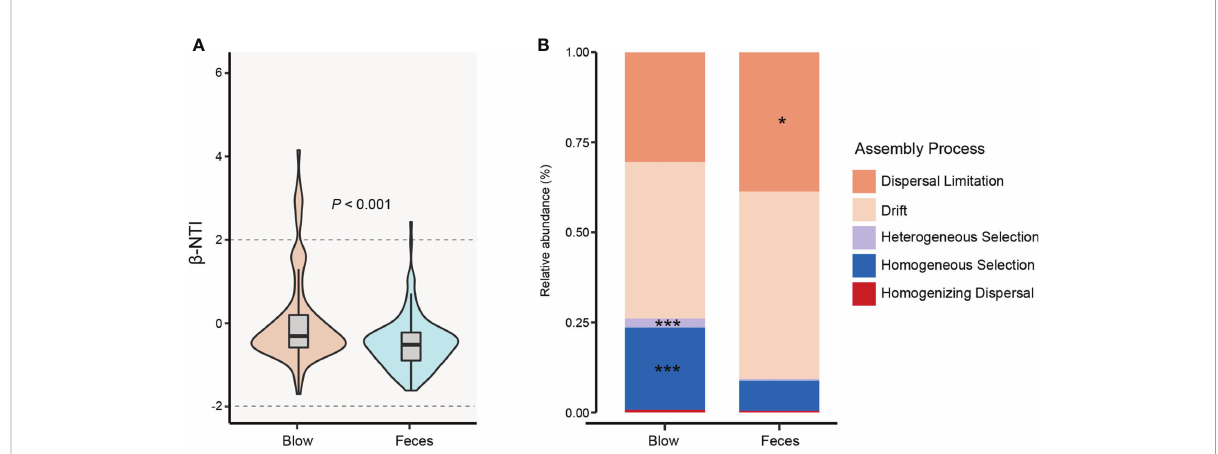
FIGURE 4 Bacterial community assembly processes for blow and feces in both dolphin species. (A) , the distribution of the bacterial weighted beta nearest taxon index ( b -NTI) in the blow and feces. The P value is from Wilcox rank sum test. (B) , the relative abundance of different assembly processes in the blow and feces. Asterisks represent statistically greater proportions at the following signi fi cance levels: * P <0.05, *** P